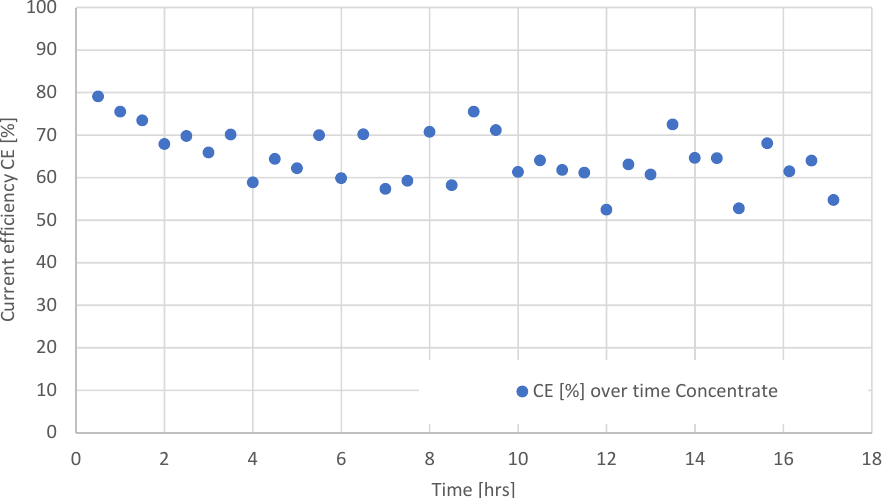
Figure 3. Current efficiency during electrodialysis at ϑ = 21 °C as function of time. Initial diluate and concentrate concentrations were 3 g/L LiCl.